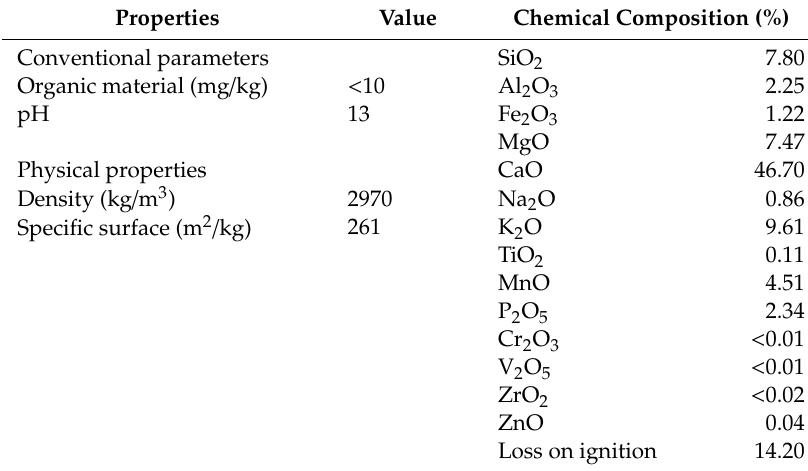
Figure 3. Particle size analysis of WA.